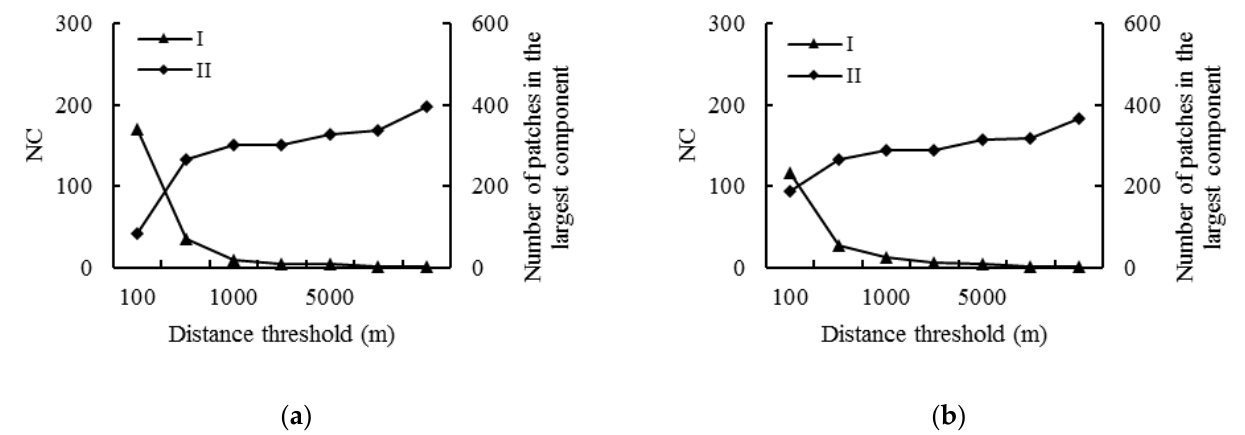
Figure 5. NC (I) and the number of patches in the largest component (II) of forest in low mountains under different distance thresholds in 2015 ( a ) and 2020 ( b ).